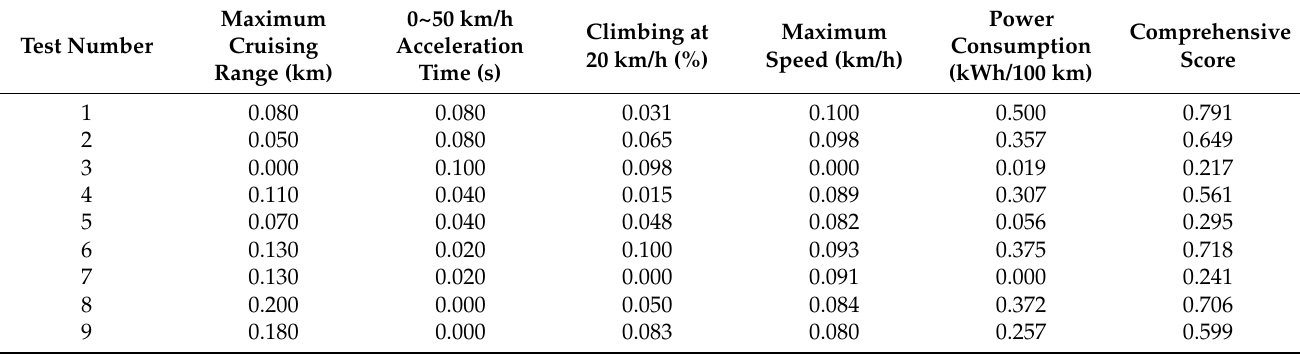
Table 13. Comprehensive scores and calculation parameter results.